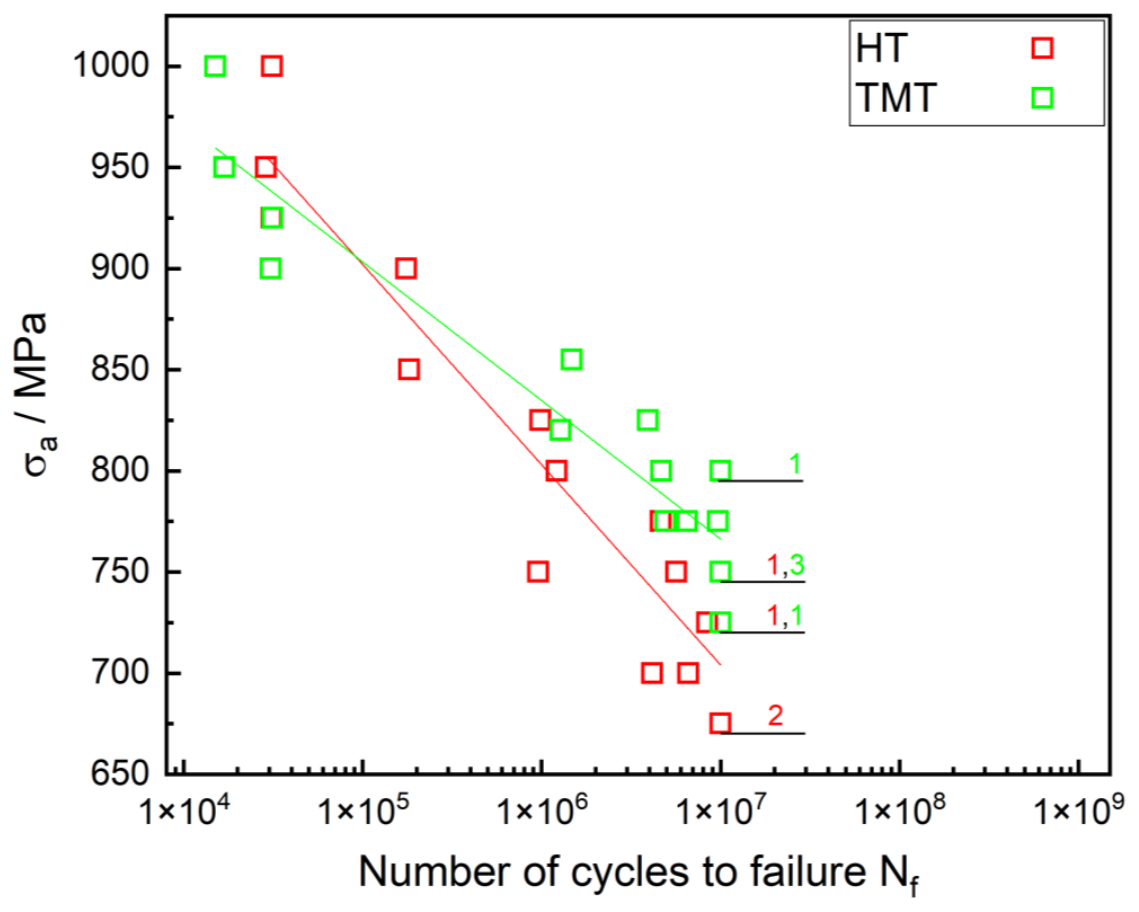
– Figure 4. S–N curve for specimens with the TMT and HT in the HCF regime. The numbers besides Figure 4. S N curve for specimens with the TMT and HT in the HCF regime. The numbers be- the data points at 10 7 cycles indicate the amount of run-out sides the data points at 10 7 cycles indicate the amount of run-out specimens.